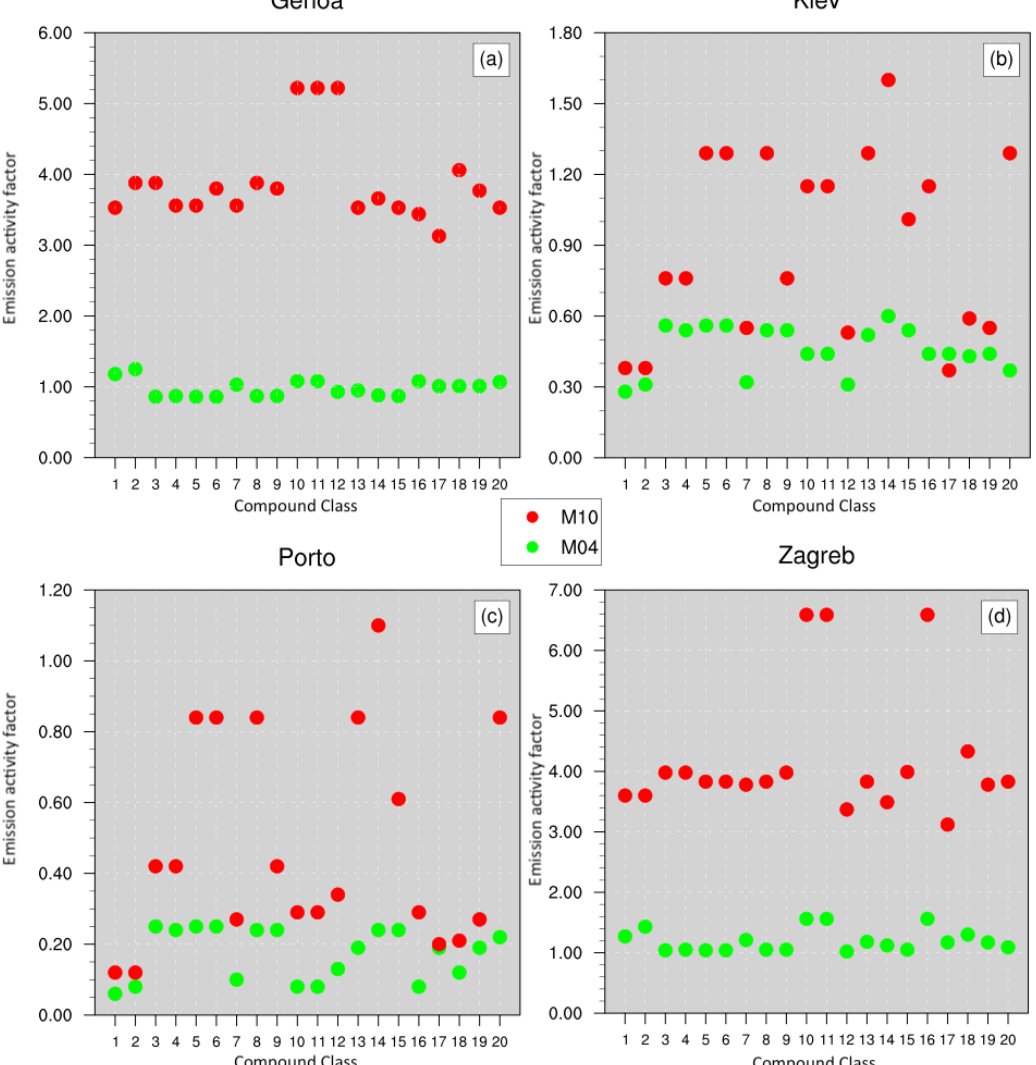
Figure 15. Total emission activity factors ( y axis, dimensionless) from M2.04 (M04) and M2.10 (M10) runs for different compound